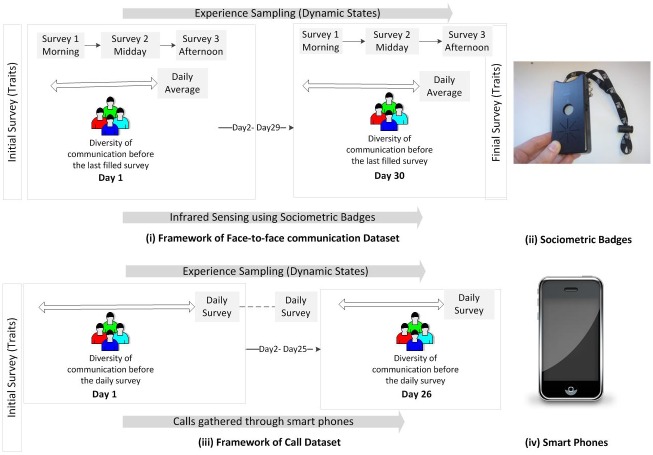
At the beginning and the end of the experiments, participants filled a survey capturing their (stable) traits.(i) Framework of the Sociometric Badges Dataset: Participants filled 3 daily surveys to measure (dynamic) states. We take the daily average of states and calculate the daily diversity in communication that took place before the last filled survey. (ii) Sociometric Badges are used to track face-to-face interactions by means of infrared (IR) sensors. (iii) Framework of the Mobile Territorial Lab project: Participants filled one daily survey to measure daily (dynamic) states. We calculate the diversity in communication that took place before the daily filled survey. (iv) Smart phones tracks the daily call social networks of participants.